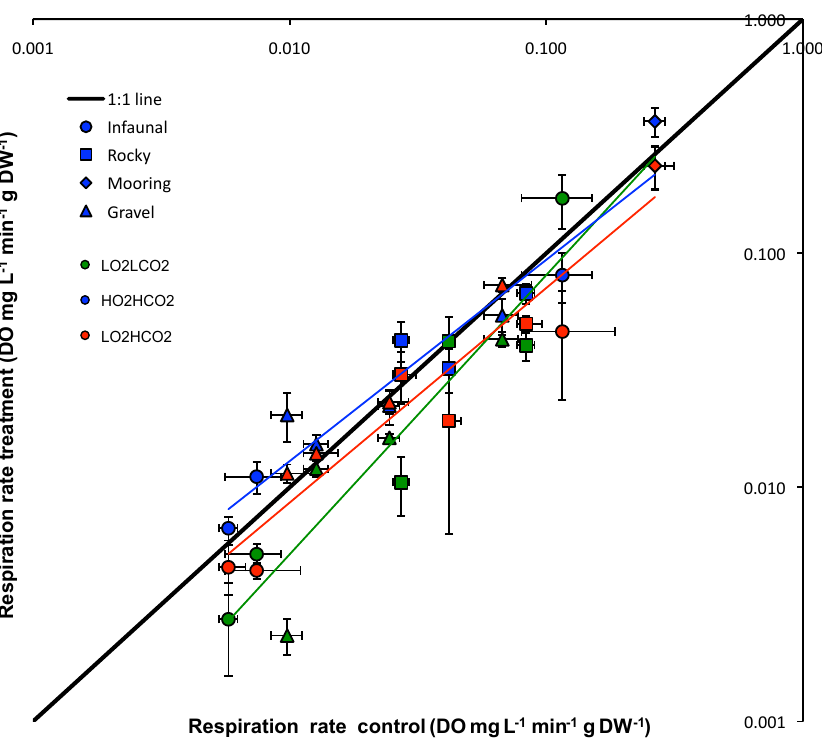
Figure 1. Respiration rate (Average ± SE) control vs. treatments of all tested species: green – L O Figure 1. blue – H O H CO ( y = 1.2905 x − 0.0122, R 2 = 0.93) and red – L O 2 2 treatment metabolism is equal to ambient